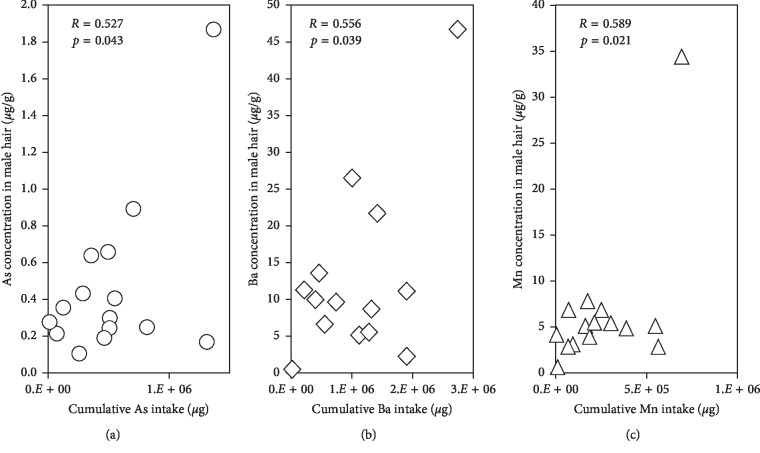
Relationships between the cumulative intakes of (a) As, (b) Ba, and (c) Mn through contaminated groundwater and their concentrations in human hair samples (Pearson correlation coefficients R > 0.500, p < 0.05).